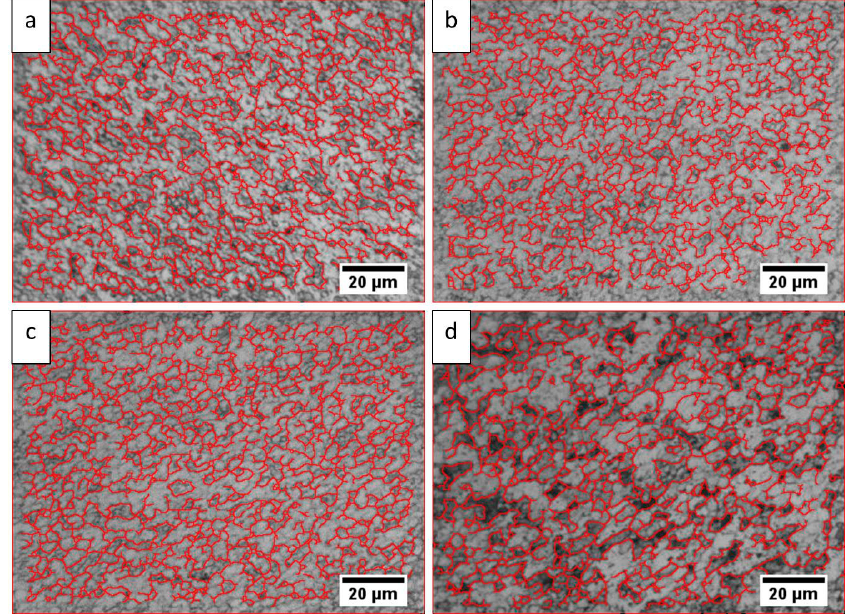
Figure 2. Optical Micro-graphs at region A for grain size measurement of ( a ) Experiment 1, ( b ) Experiment 2, ( c ) Experiment 3, ( d ) Experiment 4.